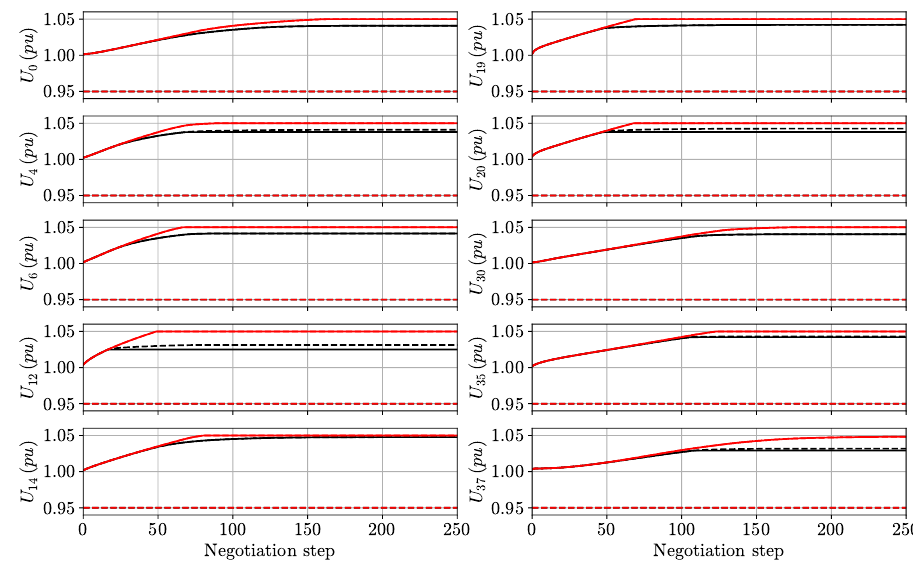
Figure 6. Evolution of the decisions on the voltage at each negotiation step for examples 4 (black) and 5 (red) and the corresponding constraints (in dashed